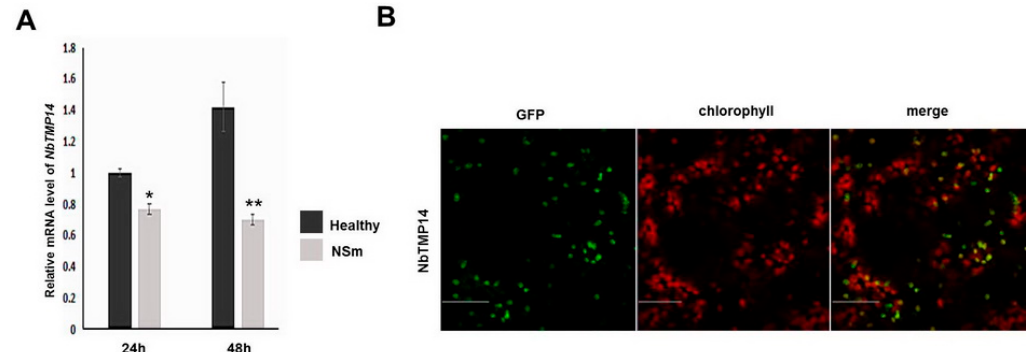
Figure 6. Transient expression of NSm downregulates NbTMP14 expression. ( A ) The expression of NbTMP14 was compared between healthy and transient expression of NSm plants at 24 and 48 h; NbTMP14 expression was significantly reduced compared with the control sample. Bars represent the mean ± standard error, ** indicates the significant differences (Student’s t -test, * p < 0.05, ** p < 0.01). ( B ) The subcellular localization of NbTMP14 in transient expression of NSm plants was not influenced by NSm. Scale bars represent 100 μ m.